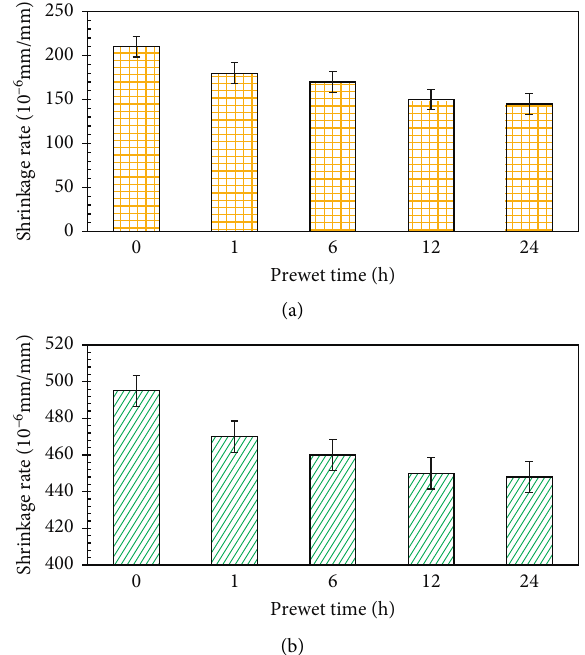
Figure 6: Shrinkage rate for different prewetting times (a) at 3d and (b)